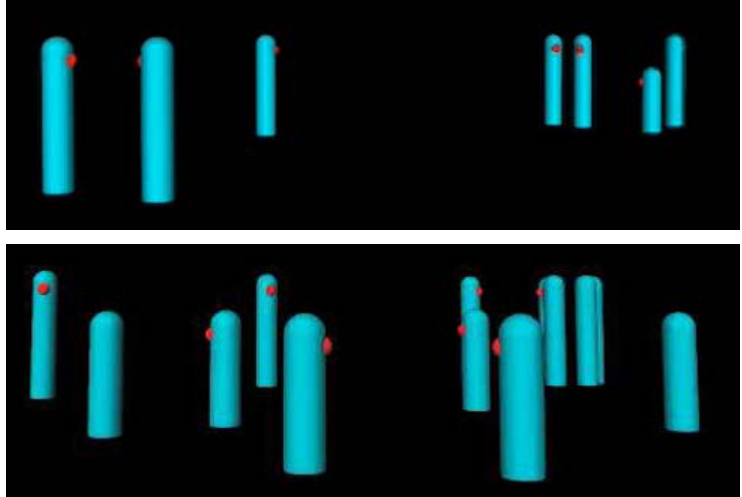
Figure 1. Still screen shots (cropped) of two of the setting animations. Note that in the absence of movement, the identity of these settings is nearly impossible to